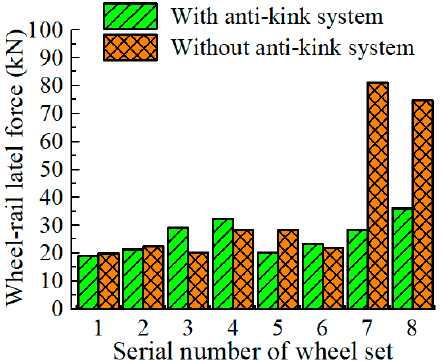
Figure 19. Wheel–rail lateral force.